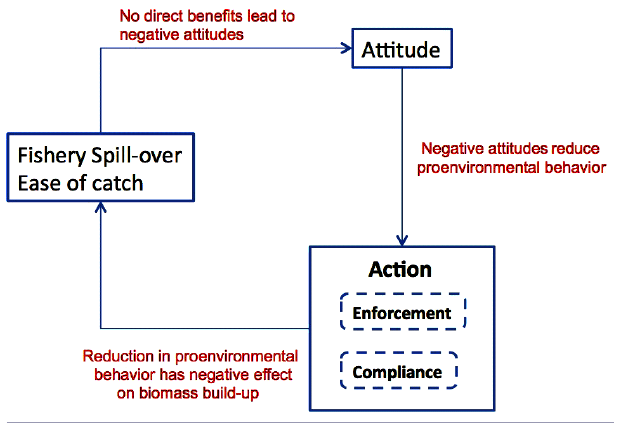
Fig. 5 . Negative reinforcing cycle of direct economic benefits and support for marine protected